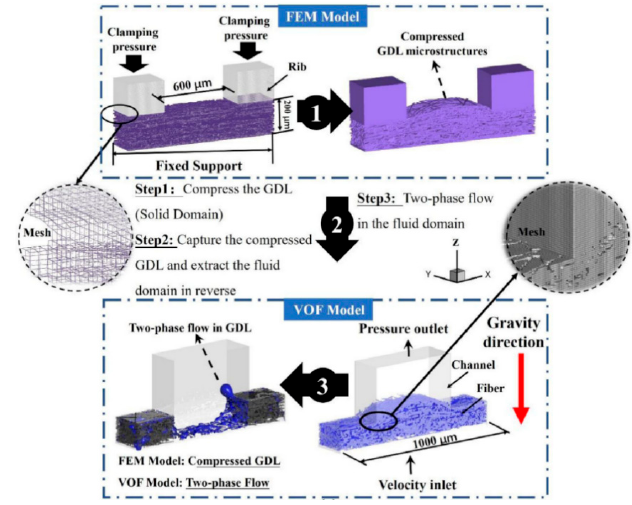
Figure 4. Schematic of numerical model, integrating FEM and volume of fluid (VOF), for wettability distribution based on GDL microstructures [30].